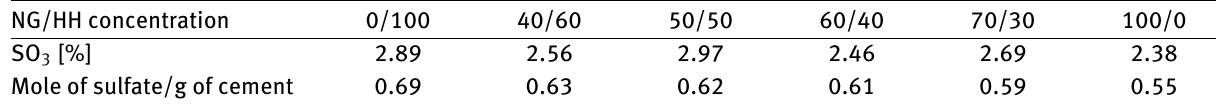
Table 3: Total SO 3 concentration within the clinker with 4% calcium sulfate provided by a mixture of NG and HH in different proportions NG/HH concentration Mole of sulfate/g of